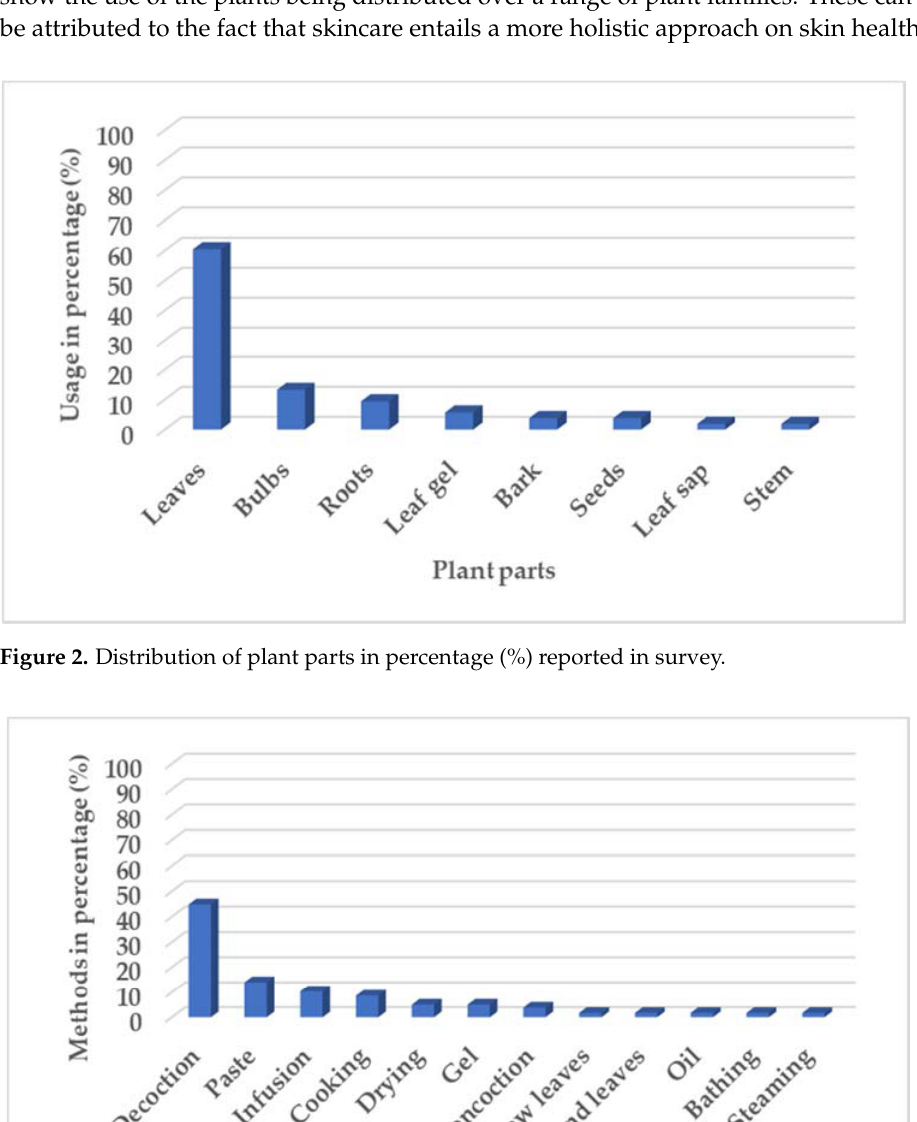
Figure 3. Preparation methods in percentage (%) reported in survey.